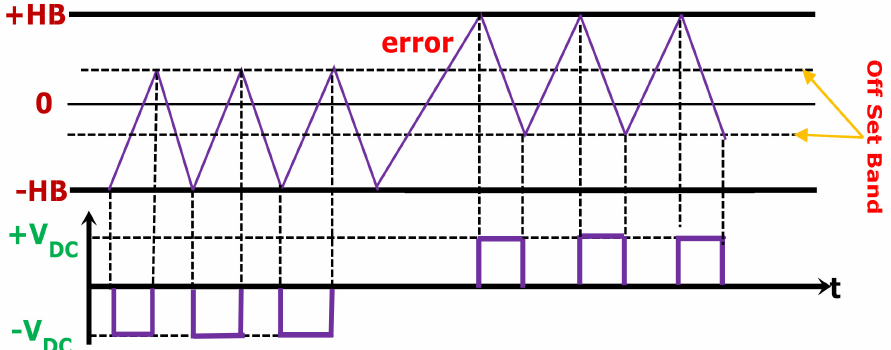
Figure 5. Analysis of offset hysteresis band current controller